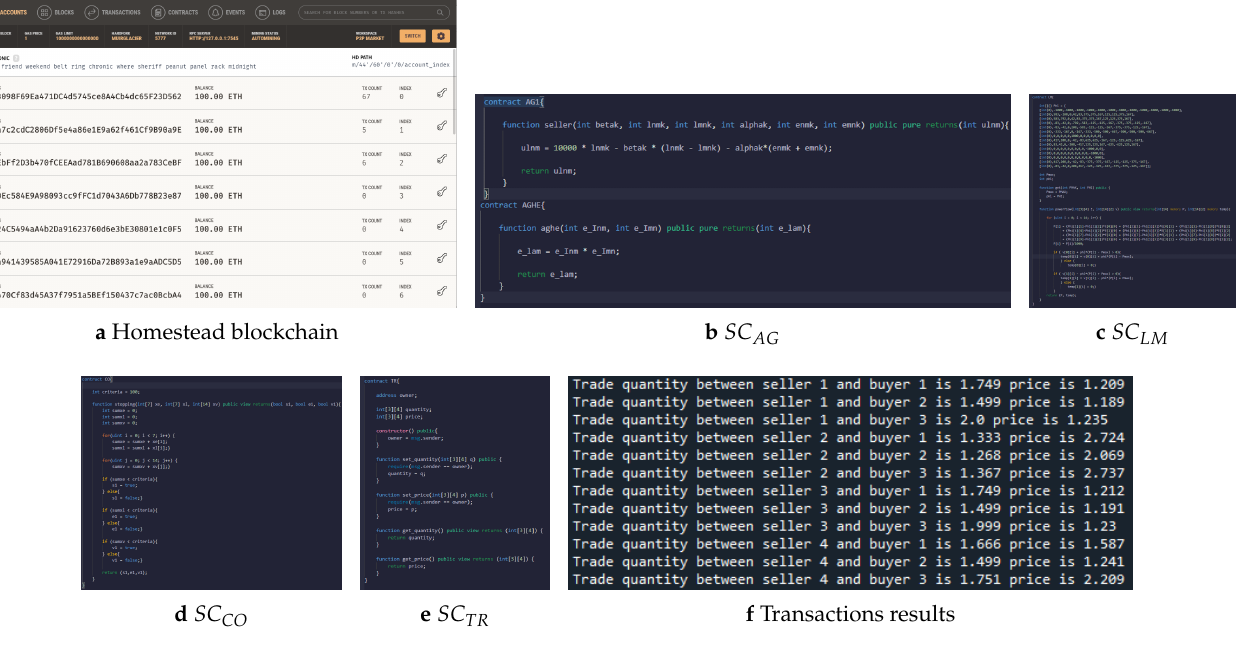
Figure 10. P2P energy-trading blockchain, smart contracts, and transactions results stored on the